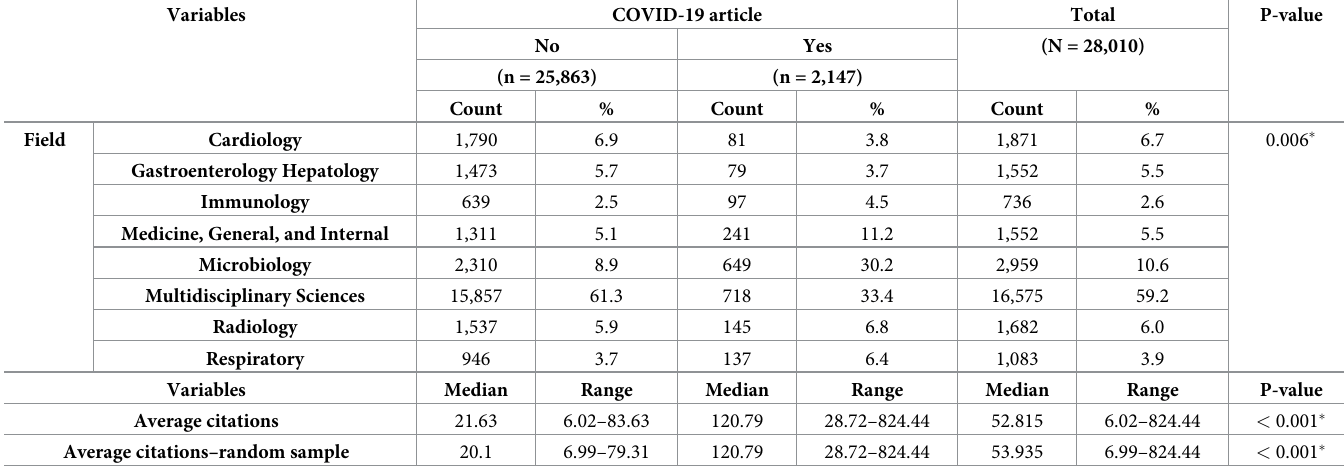
Table 2. Quantity of citations for Covid-19 and non-Covid-19 articles with median and range values across all fields.